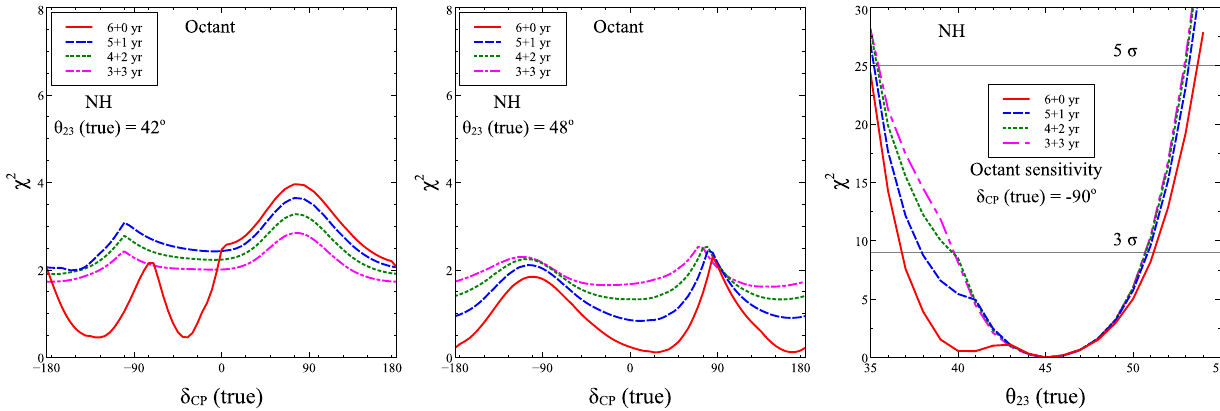
Fig. 5 Octant sensitivity in NH for different combinations of neutrino and antineutrino ratio. Octant χ 2 vs δ CP (true) is presented in the left and middle panel for θ 23 = 42 ◦ and 48 ◦ respectively. Octant χ 2 vs θ 23 (true) is presented in the right panel for δ CP = − 90